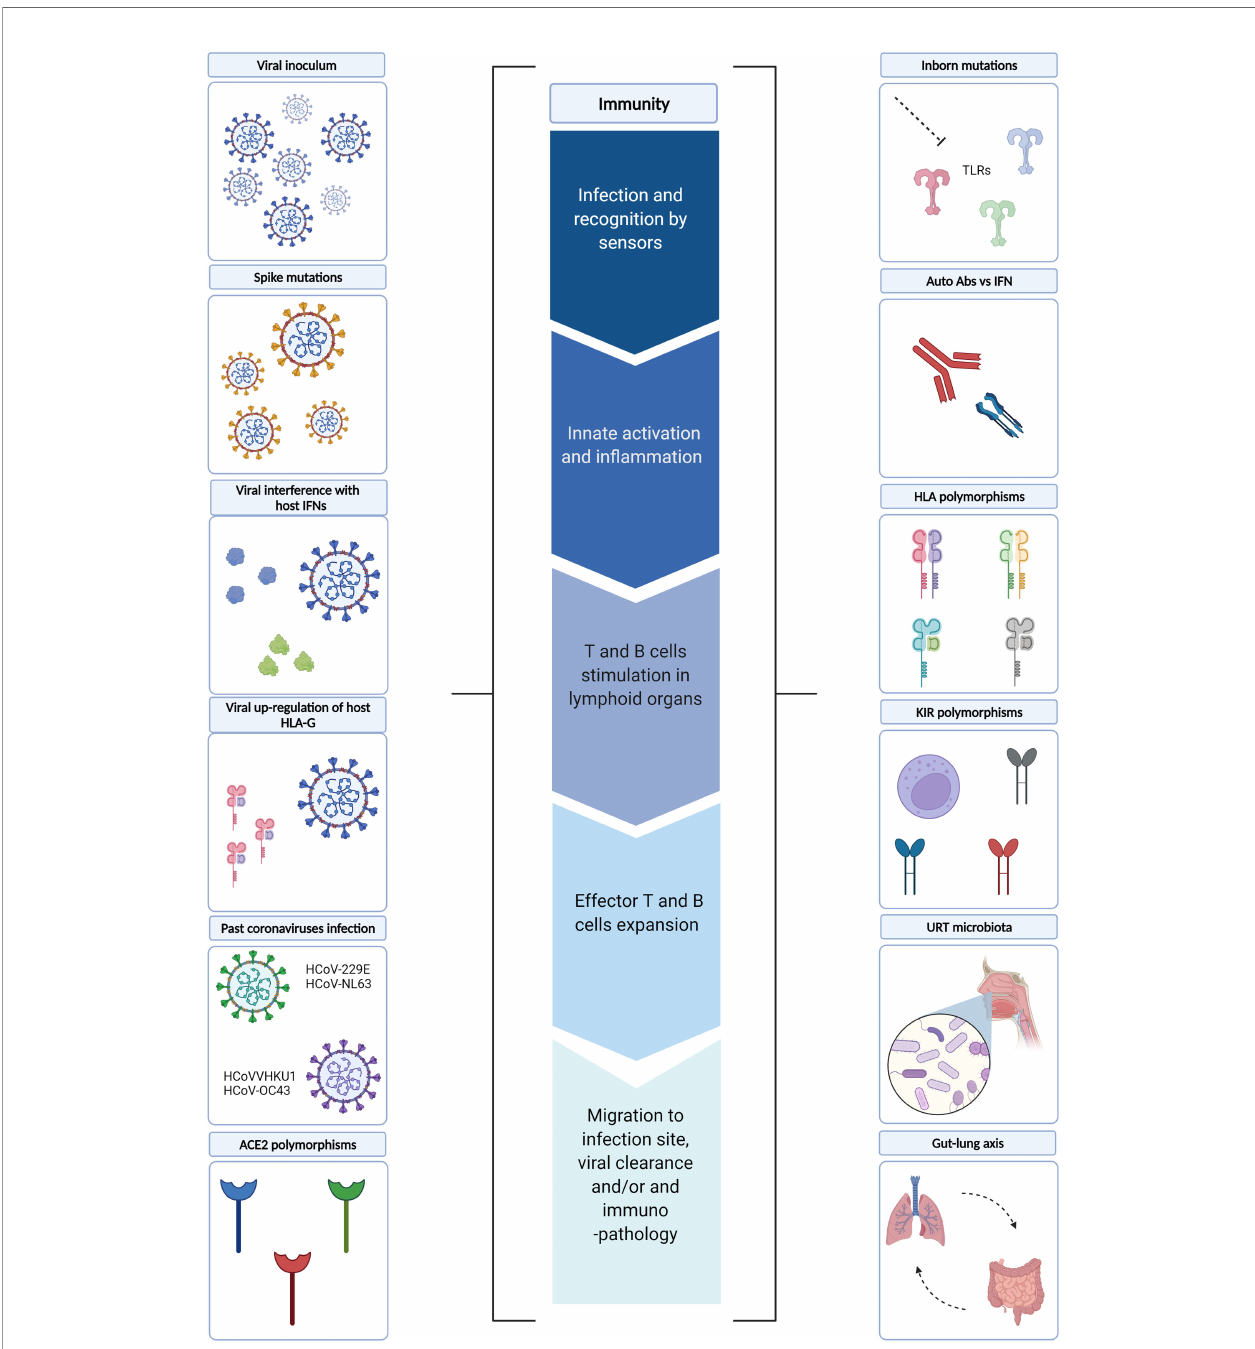
FIGURE 2 | Underlying mechanisms of immune dysregulation. Several viral and host factors have been described as in fl uencing one or more steps of the immune response during SARS-CoV-2 infection. In particular, the early phases of the immune response may be in fl uenced by i) viral factors, such as viral inoculum, Spike mutations and viral interference of host IFN pathways, as well as ii) host factors, such as ACE2 polymorphisms and URT microbiota. Whereas viral up-regulation of host HLA-G, inborn host mutations, auto-reactive Abs vs IFN, HLA and KIR polymorphisms, past coronavirus infections may in fl uence the later phases of immune responses. In this context, gut-lung axis perturbations may further fuel systemic in fl ammation. TLRs, Toll-like receptors; IFN, Interferon; Abs: Antibodies; HLA, Human Leukocyte Antigens; KIRs, Killer Cell Immunoglobulin-like Receptors; URT, Upper Respiratory Tract; ACE2, Angiotensin-converting Enzyme 2. Created with